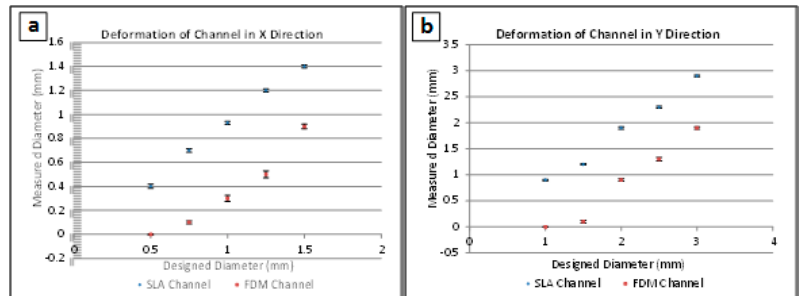
Figure 5. Top view of the assembled automated ELISA bioassay platform. Test wells are indicated by